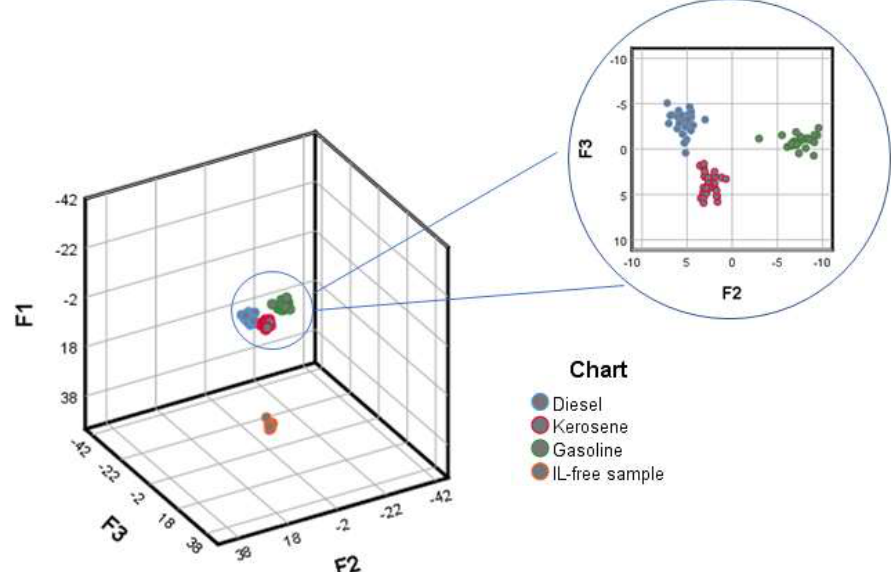
Figure 2. Discriminant scores obtained for all the samples (D 100×330 ).